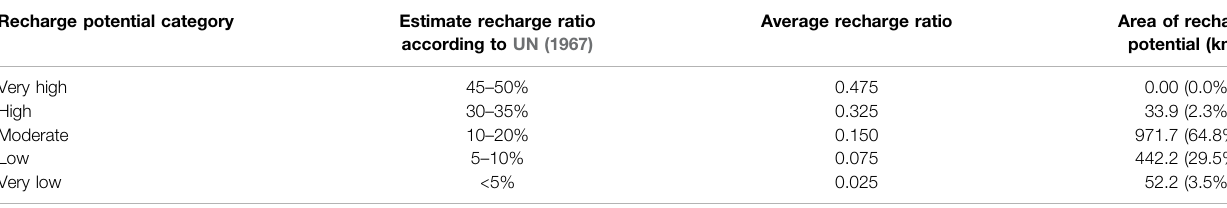
TABLE 5 | Recharge potential categories and area of recharge potential according to UN (1967). Recharge potential category Estimate recharge ratio according to UN (1967)